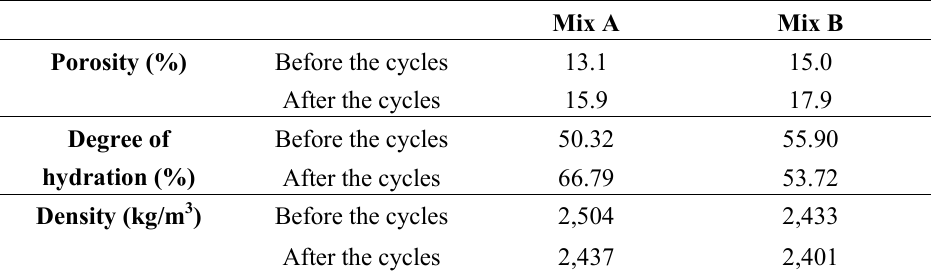
Table 3. Microstructural characterisation of the concrete specimens.